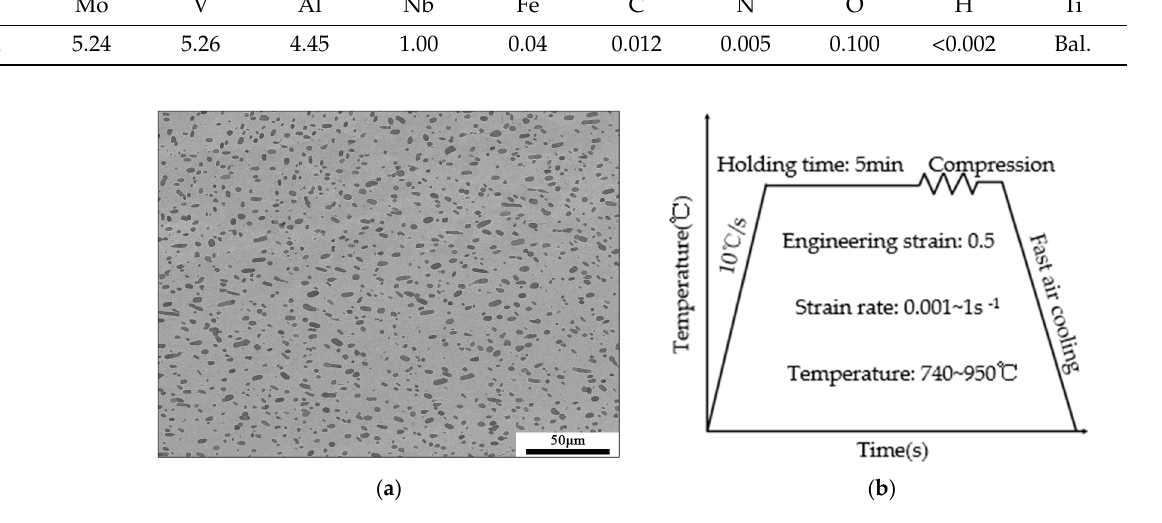
Figure 1. ( a ) Original microstructure of the Ti − 65541 alloy, and ( b ) experimental flow diagram of the hot compression tests.